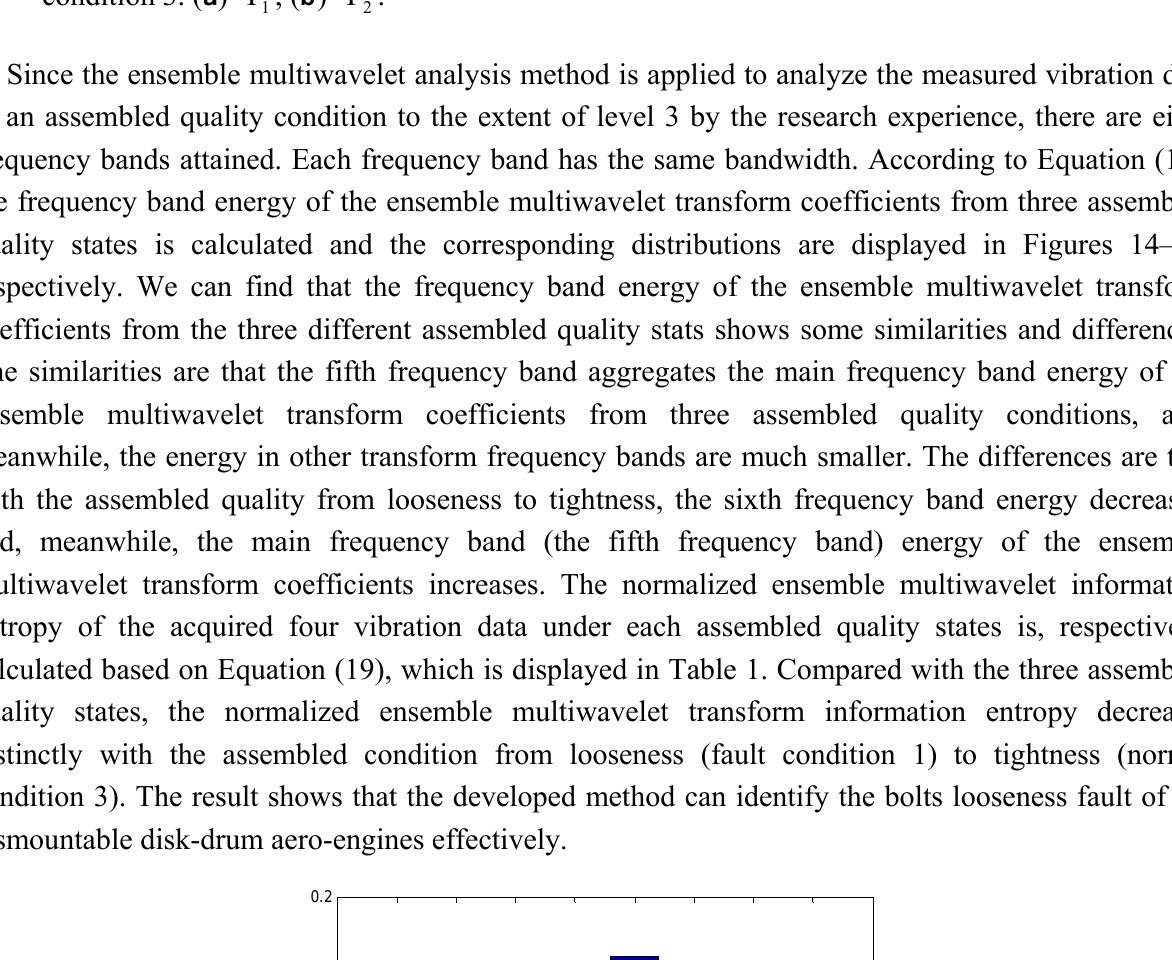
Figure 13. The multiwavelet condition 3. ( a )